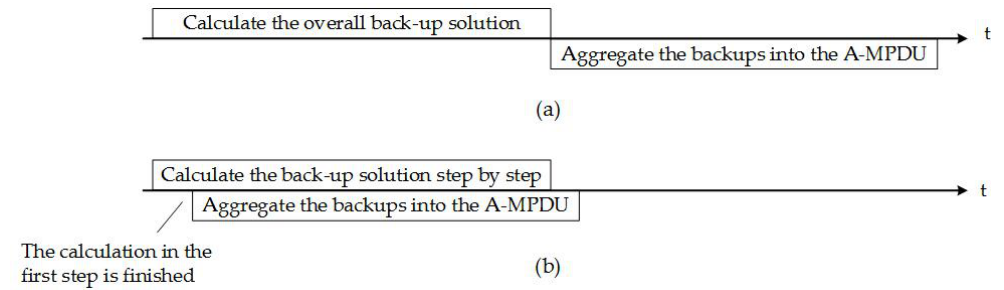
Figure 9. The sequence diagrams of the calculation of the backup solution and the aggregation of the backups. ( a ) The sequence diagram without parallel processing. ( b ) The sequence diagram with parallel